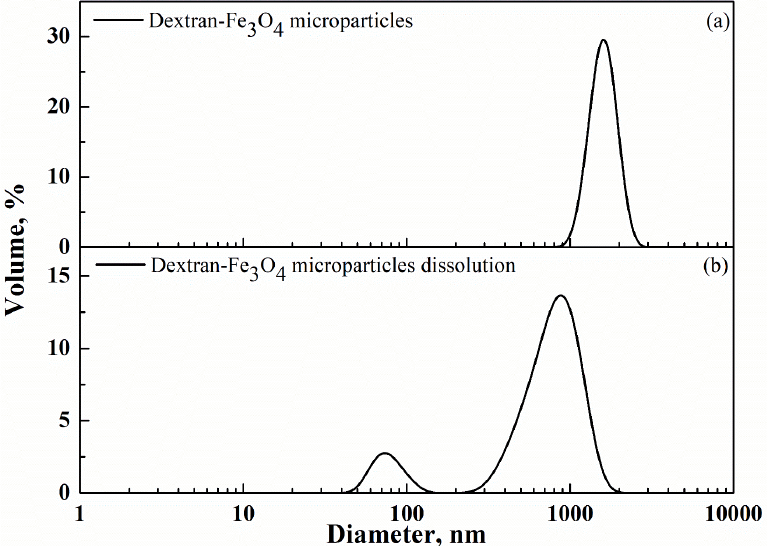
Figure 3. DLS traces of: ( a ) starting dextran-Fe 3 O 4 microparticles and ( b ) intermediate dex- tran-Fe 3 O 4 microparticles dissolution. microparticles